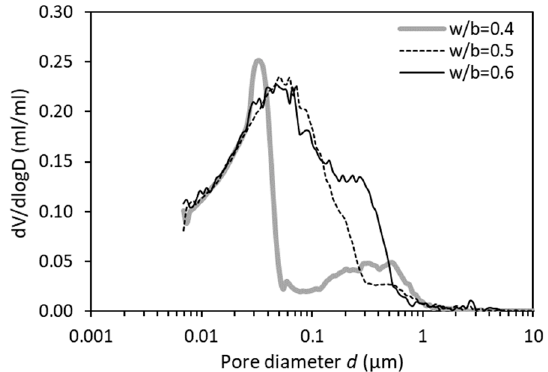
Figure 7. Differential curves of ink-bottle pore size distribution for OPC pastes (28 days) with w/b of 0.4, 0.5 and 0.6.